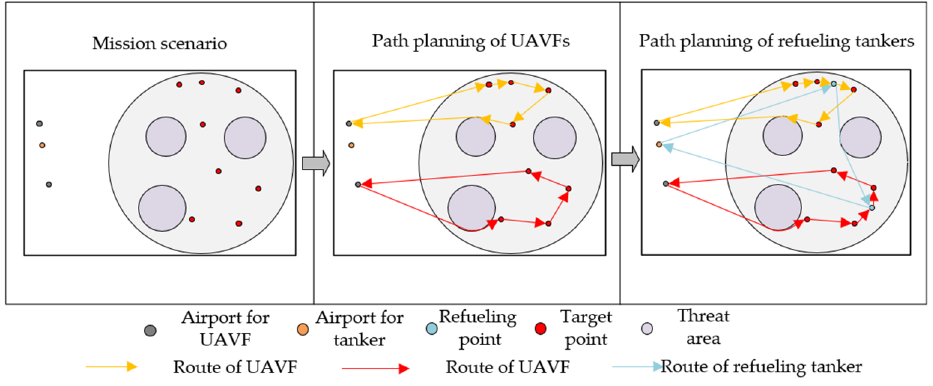
Figure 5. Collaborative path-planning process.